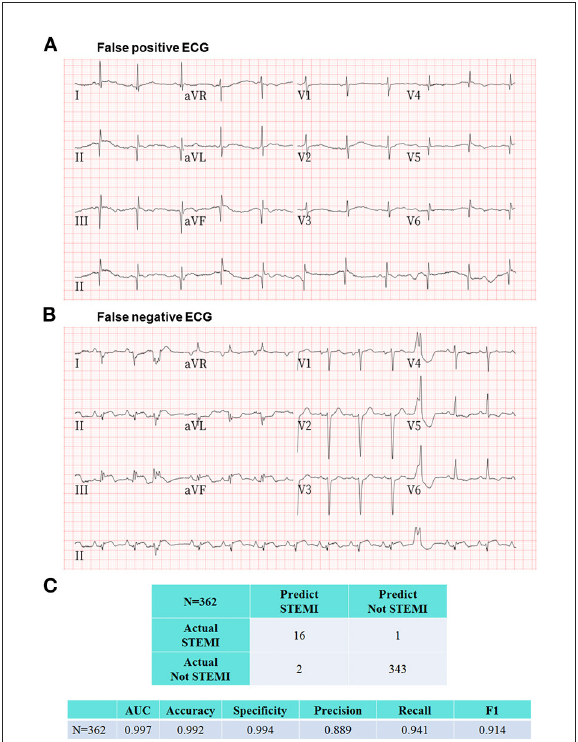
FIGURE5 Representative ECGs of false positive and false negative labeling by the proposed AI model. (A) This prehospital ECG showing pathological Q waves in the inferior and anterolateral leads was classified as STEMI by AI. The ground truth committee interpreted this ECG as recent or old myocardial infarctions and judged this AI labeling as a false positive case. (B) There was only one ECG with a false negative labeling by AI as “Not STEMI,” which was interpreted as “STEMI” according to the adjudication by the ground truth committee. Interestingly, this patient was diagnosed with a recent myocardial infarction by the cardiologist in charge at the destination hospital after incorporating more hospital-based information including historical ECGs and laboratory data, and did not require PPCI. (C) The evaluation metrics including area under the receiver operating characteristic curve, accuracy, specificity, precision, recall, and F1 score to assess the overall AI performance in the remote detection of STEMI from 362 prehospital 12-lead ECGs were 0.997, 0.992, 0.994, 0.889, 0.941, and 0.914, respectively.